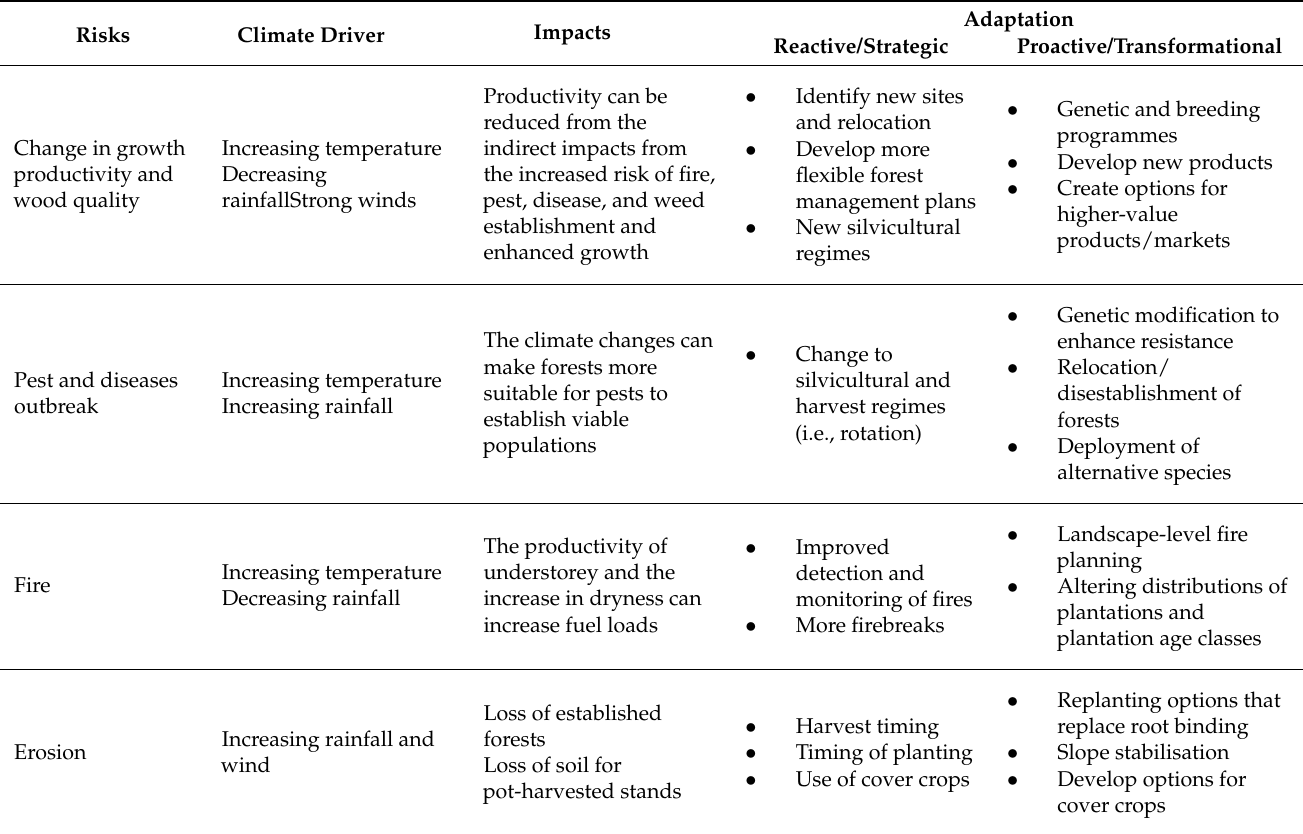
Table 3. Climate drivers, risks, and their adaptation options for forest operations of radiata pine. Source: Dunningham et al. [79] and Meason and Mason